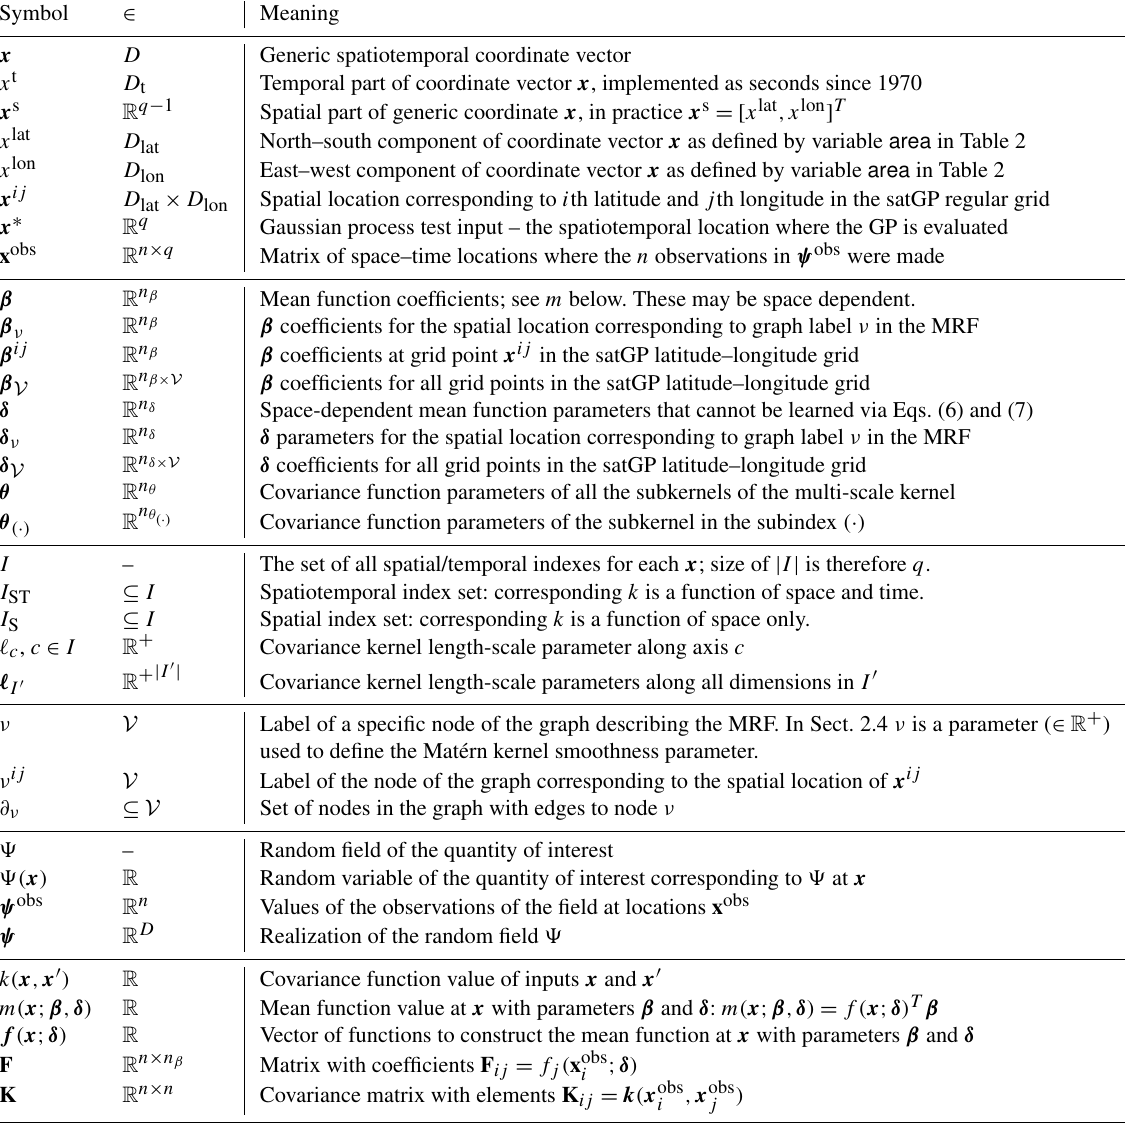
Table 1. Most commonly used notation related to inputs and mean/covariance functions in Sect. 2 and the Markov random field in Sect. 2.3.1. The second column gives the set in which the symbol belongs – or in some cases the set of which the symbol is a subset. The domain sets in the second column are defined as D lat (cid:44) (cid:2) lat min , lat max (cid:3) , D lon (cid:44) (cid:2) lon min , lon max (cid:3) , D t (cid:44) R + , and D (cid:44) D lat × D lon × D t ⊂ R q , and V denotes the set of nodes in the graph described in Sect.